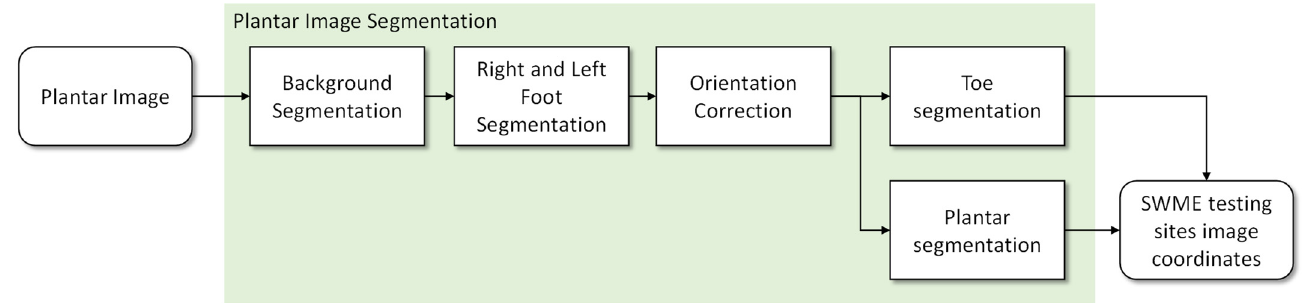
Figure 3. Functional diagram for the proposed plantar image segmentation algorithm.